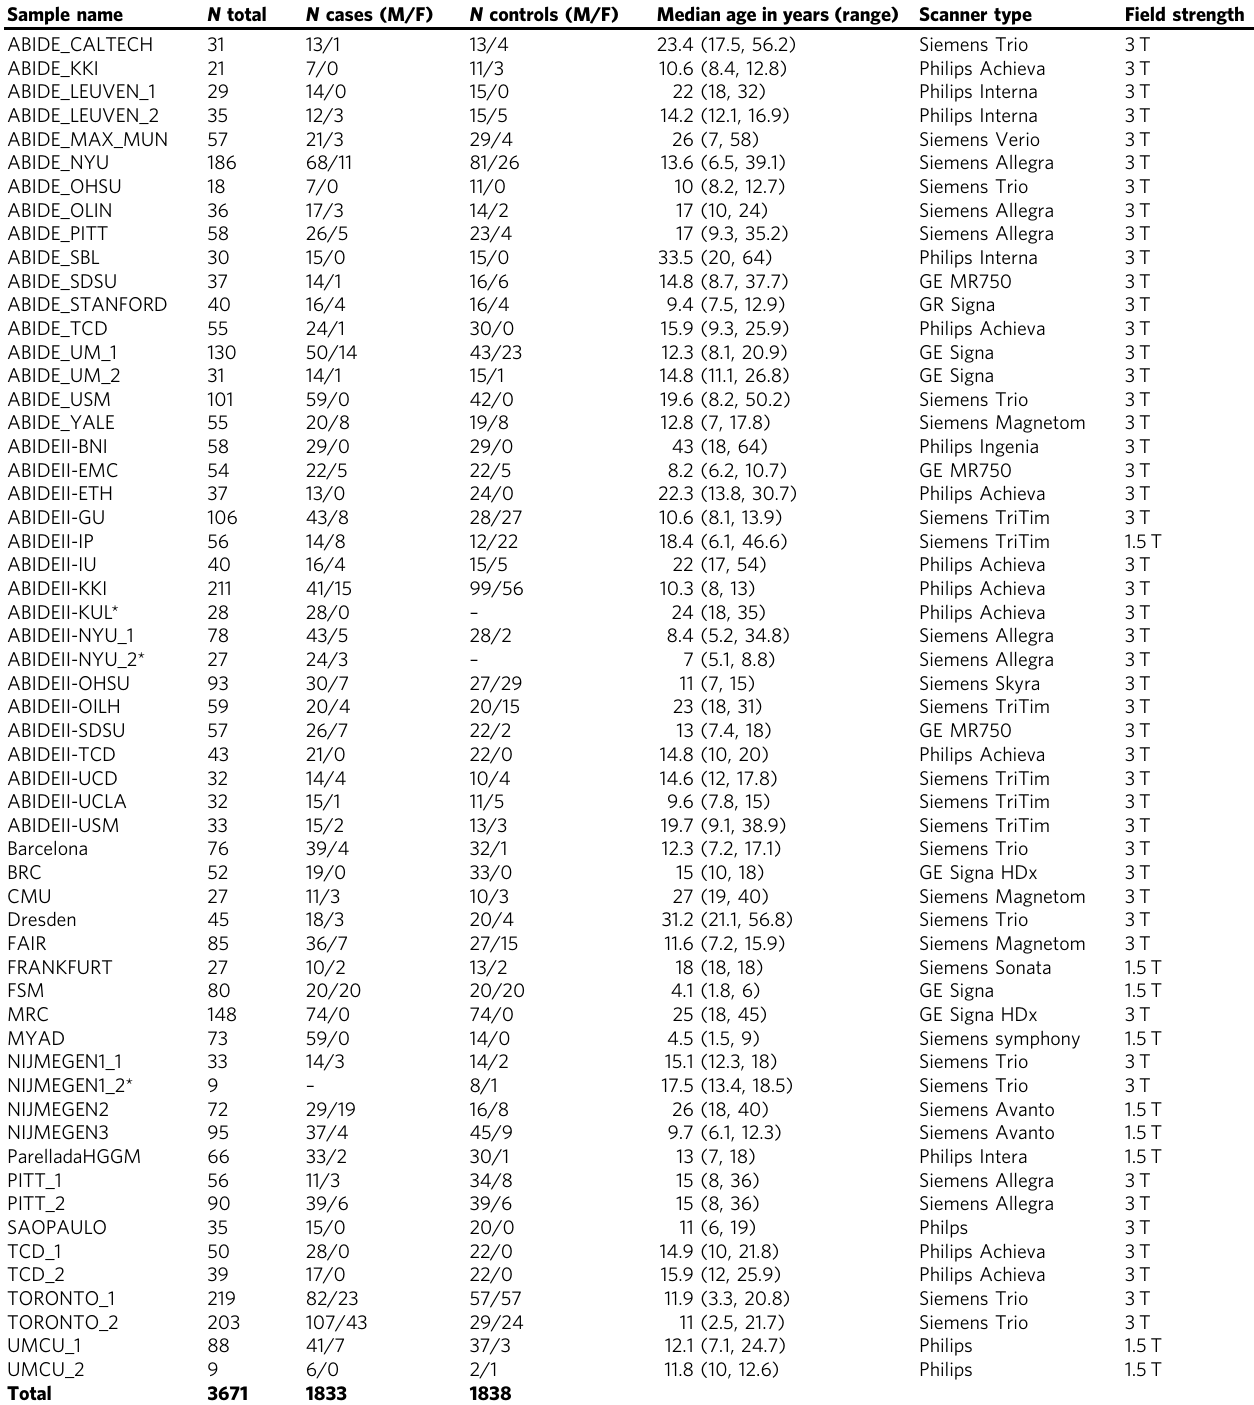
Table 1 Characteristics of the different data sets of the ENIGMA ASD working